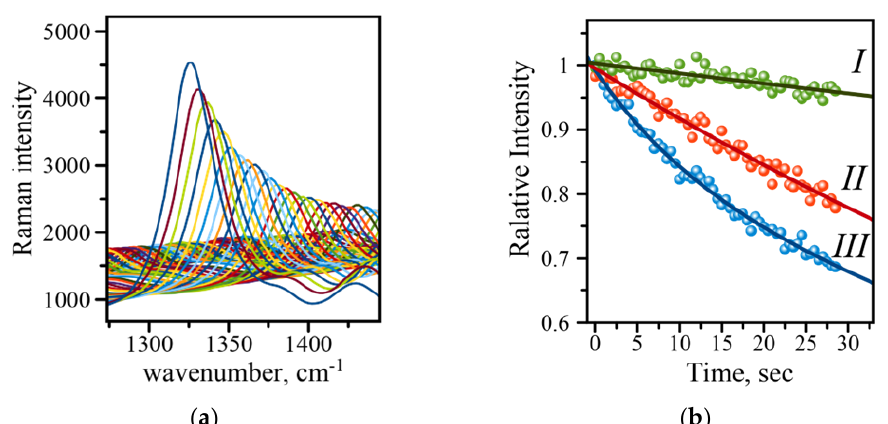
Figure 5. ( a ) Raman intensity decline with time demonstrated on an example of the 1336 cm − 1 band of the symmetric stretch of the amino group in the NBT molecule (measured at 150 mW laser power; ( b ) comparison of intensity decline at three different output powers: (I) 100 mW (green), (II) 125 mW (red), (III) 150 mW (blue). Solid lines are exponential function fits to the data points recorded with 0.5 s acquisition time.